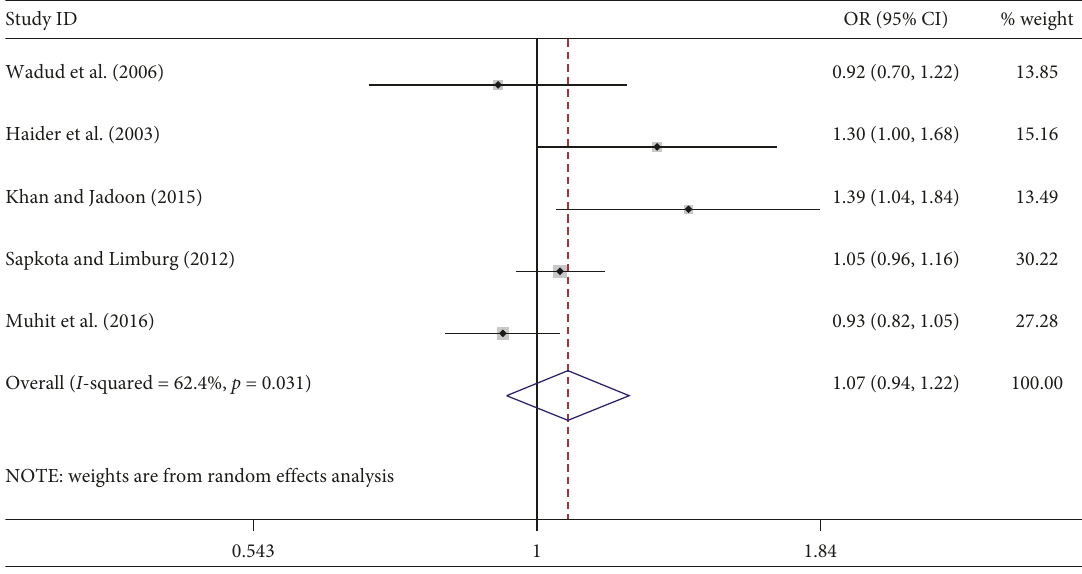
Figure 5: Forest plot showing the meta-analysis of CSC by sex on an eye basis at visual < 6/18 level. CSC � cataract surgical coverage; OR � odds ratio; CI � confidence interval.